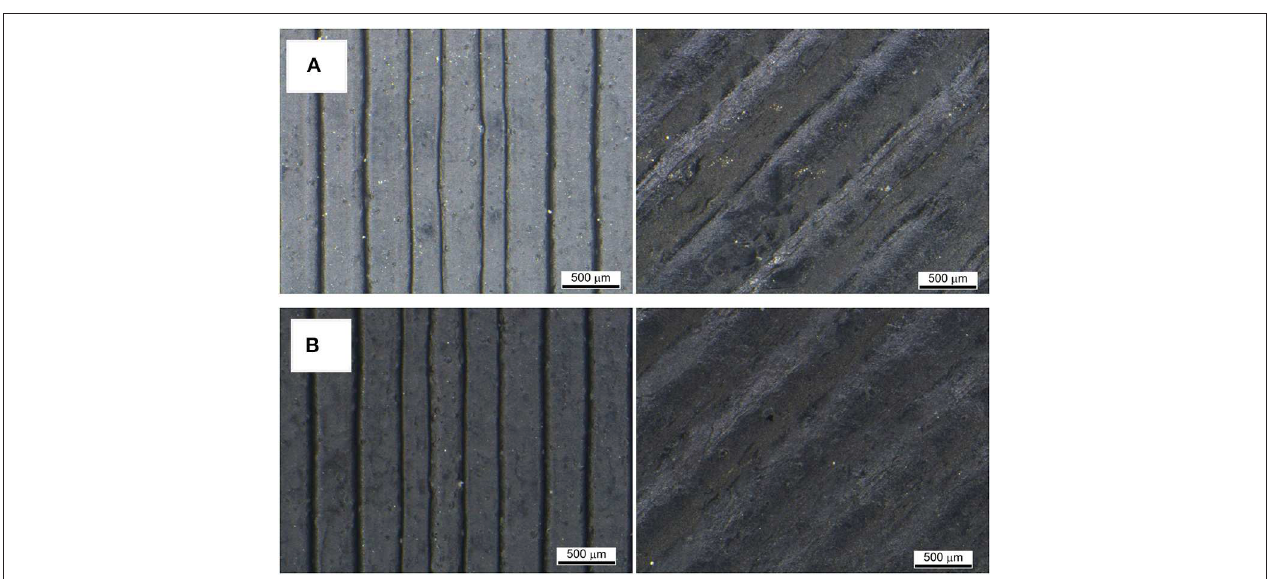
FIGURE 12 | Optical micrographs of HC (right) and H45 (left) samples: (A) before, and (B) after 50 cycles under tensile loading.